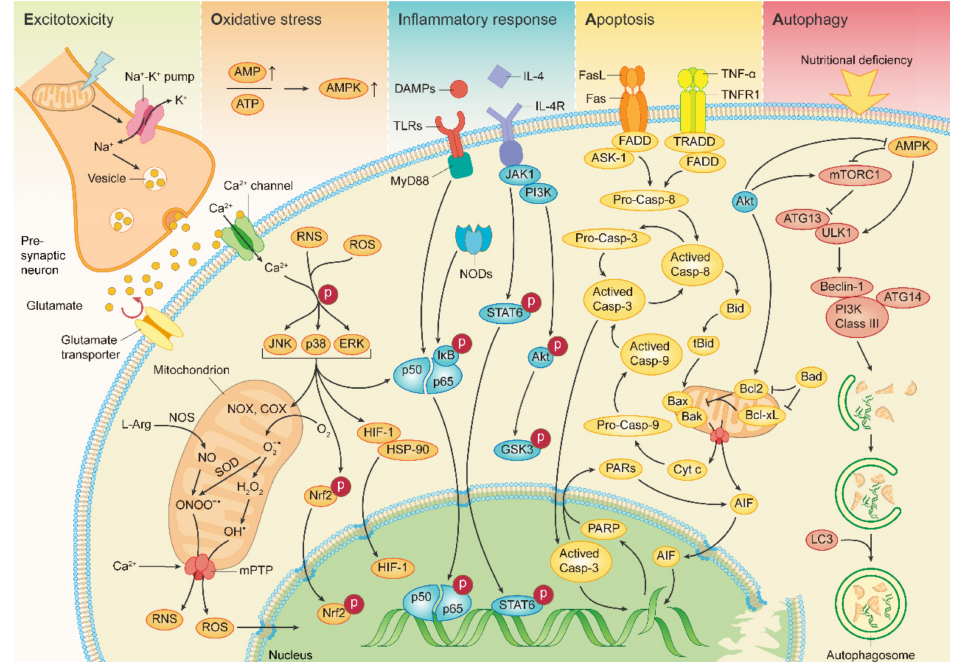
Figure 2. Selected molecular mechanisms involved in the pathophysiological processes of stroke. Excitotoxicity: the impaired energy supply depolarizes presynaptic neurons, and massive glutamate release promotes inward calcium flow. Oxidative stress: the mitochondrial oxidative respiratory chain is inhibited, generating excess ROS/RNS and triggering a cascade of downstream responses. Inflammatory response: neuronal immune cells respond to external stimuli via receptors such as TLRs and IL-4R, mediating the synthesis and secretion of a series of inflammation-related proteins. Apoptosis: apoptosis-related proteins are activated via different pathways and ultimately drive apoptosis. Autophagy: regulated by both mTOR and AMPK proteins, the ULK1 kinase complex is activated, promotes autophagosome maturation, and completes the autophagic process step by